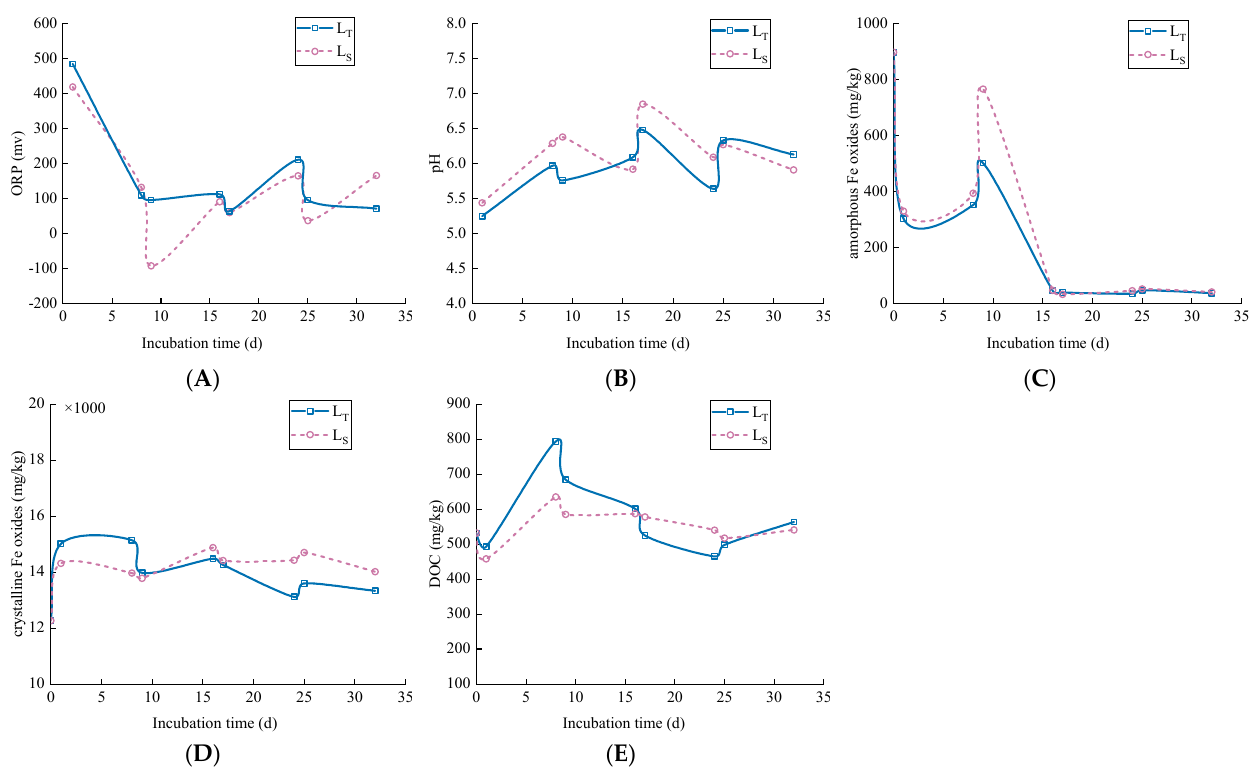
Figure 2. Changes of ( A ) pH, ( B ) ORP, ( C ) amorphous Fe oxides, ( D ) crystalline Fe oxides, ( E ) DOC in the L T and the L S over time under intermittent